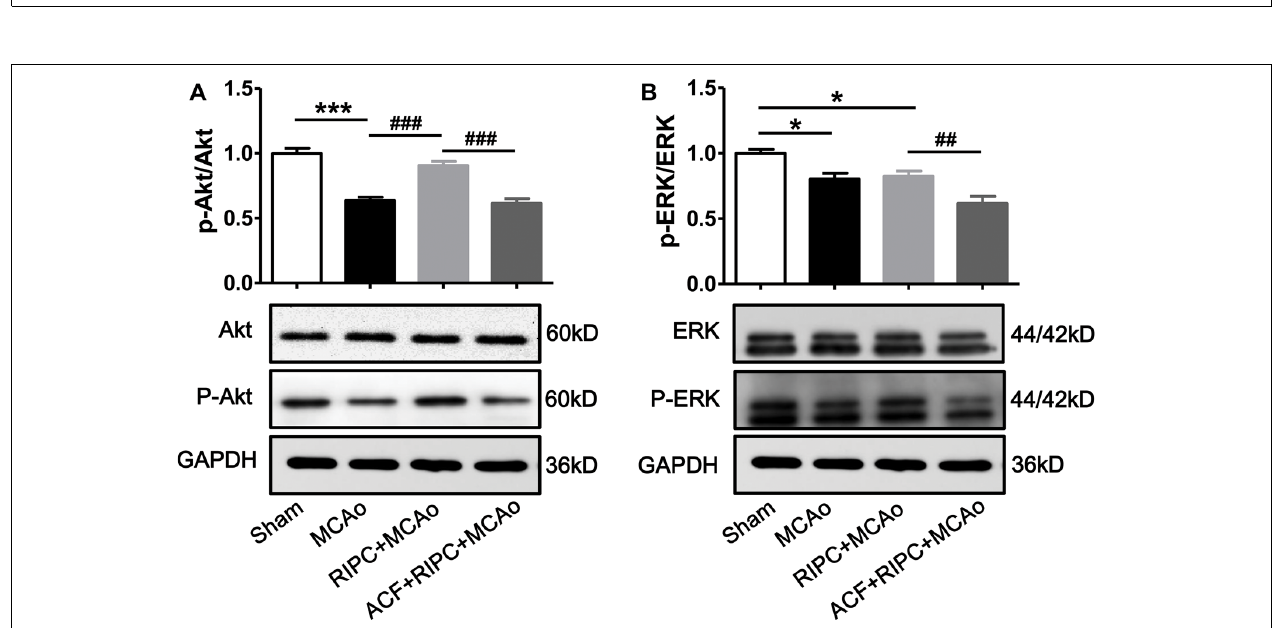
FIGURE 6 | The effect of RIPC and ACF on the activation of Akt and ERK signaling pathway. (A) Statistical data of the ratio of p-Akt to total Akt and representative images of western blot of total Akt and p-Akt. A total of 4 groups were assessed: Sham, MCAo, RIPC+MCAo, ACF+RIPC+MCAo. (B) Statistical data of the ratio of p-ERK to total ERK and representative images of western blot of total ERK and p-ERK in penumbra tissues ( N = 5–6 per group). Statistical analysis was performed by ANOVA. * , *** vs. Sham, p < 0.05, 0.001 respectively, ##,### vs. MCAo, RIPC+MCAo, p < 0.01, 0.001, respectively.